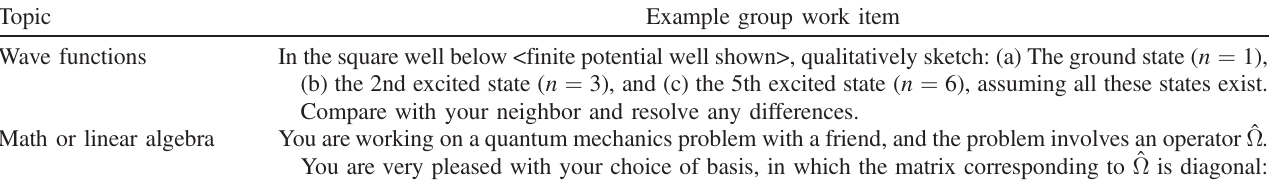
TABLE I. Some topics emphasized in guided group work sessions and an example question for each topic. This is not an exhaustive list of topics or questions related to these